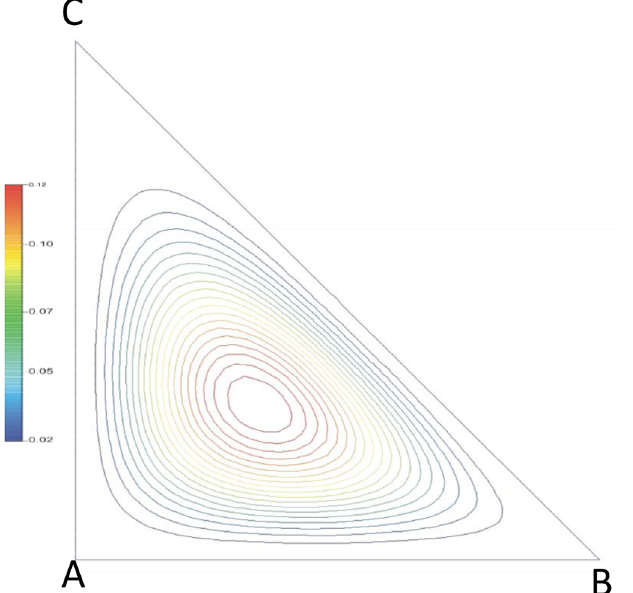
Fig. 7. Stream function contour of the triangular cavity with boundary condition on the walls, AB, u =1, CA, ∂ u ∂ Pr = 0.71, Ra =